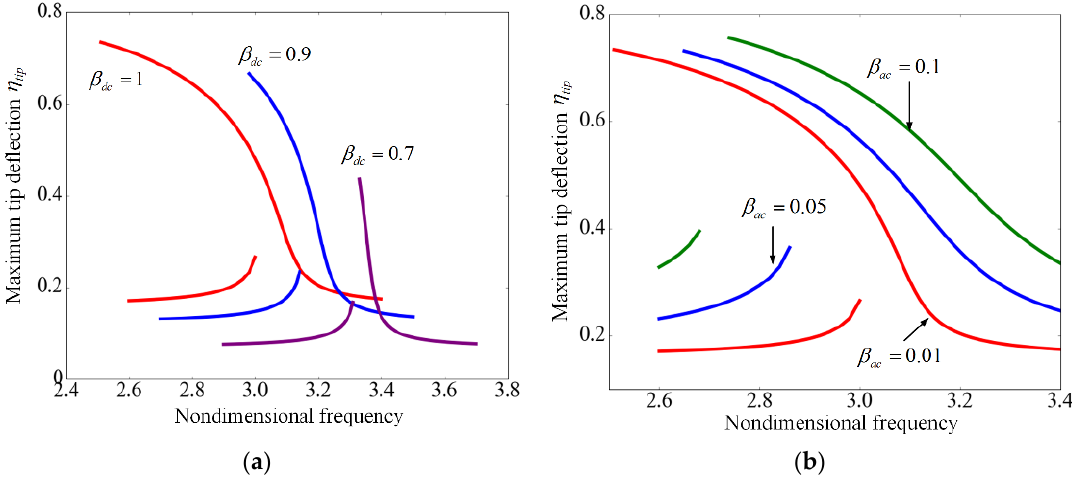
Figure 14. Frequency response curves of suspended microchannel resonators for different ( a ) DC voltages β dc with β ac = 0.01; and ( b ) ac voltages β ac with β dc = 1.0 when ˆ U = 0.